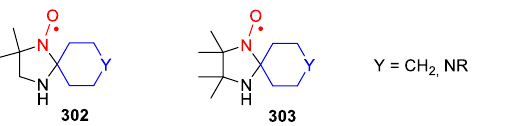
Figure 10. Structures of dimethyl and tetramethyl SNRs of the imidazolidine type. Condensation of 1,2-diamino-2-methylpropane with cyclohexanone or N -protected piperidones 58a,d,g in the presence of PTSA generates corresponding imidazolidines